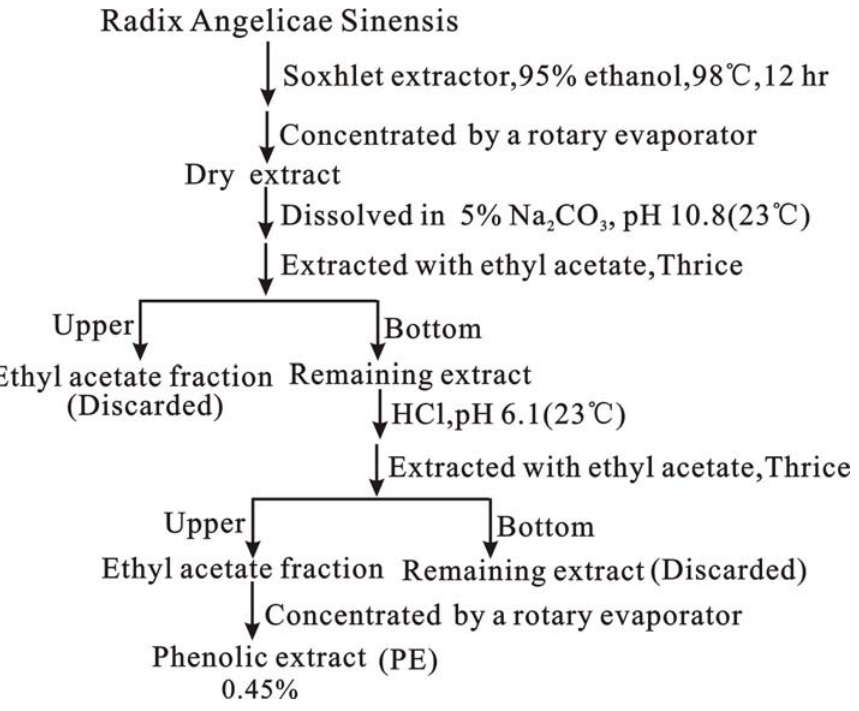
Figure 4. The preparation of phenolic extract (PE) of Radix Angelicae Sinensis using a pH adjustment